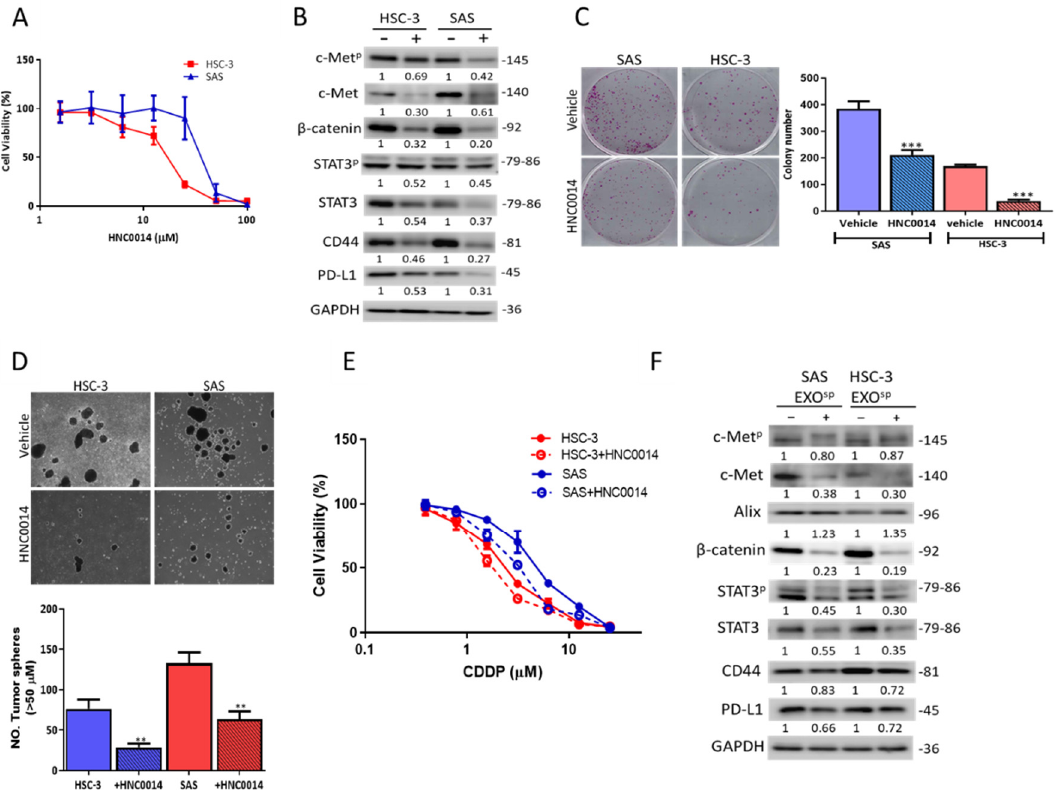
Figure 3. HNC0014 treatment inhibited tumorigenic and stemness properties via downregulating c-Met / STAT / CD44 / PD-L1 expression. ( A ) HNC0014 treatment resulted in a dose-dependent reduction in cell viability in both SAS and HSC-3 cells. ( B ) Western blots of HNC0014-treated ( + ) SAS and HSC-3 cells exhibited lower expression levels of c-Met, c-Met p , STAT3, STAT3 p , PD-L1, CD44, and β -catenin. HNC0014 treatment significantly reduced the colony-forming ( C ) and tumorsphere-forming abilities ( D ) of both SAS and HSC-3 cells. Magnification 4X. ( E ) HNC0014 pretreatment of HSC-3 (2 µ M, 24 h) and SAS (5 µ M, 24 h) increased the sensitivity of Exo sp -transformed HNSCC cells to CDDP treatment. ( F ) HNC0014 treatment significantly reduced the expression of STAT3, STAT3 p , PD-L1, c-Met, c-Met p , CD44, and β -catenin from both exosomes derived from HSC-3 and SAS tumorspheres. ** p < 0.01, *** p < 0.001.